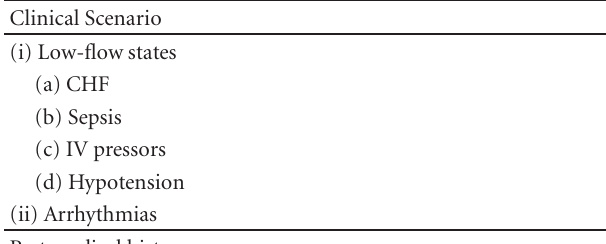
Table 3: Findings concerning for mesenteric ischemia and infarc- tion within pneumatosis